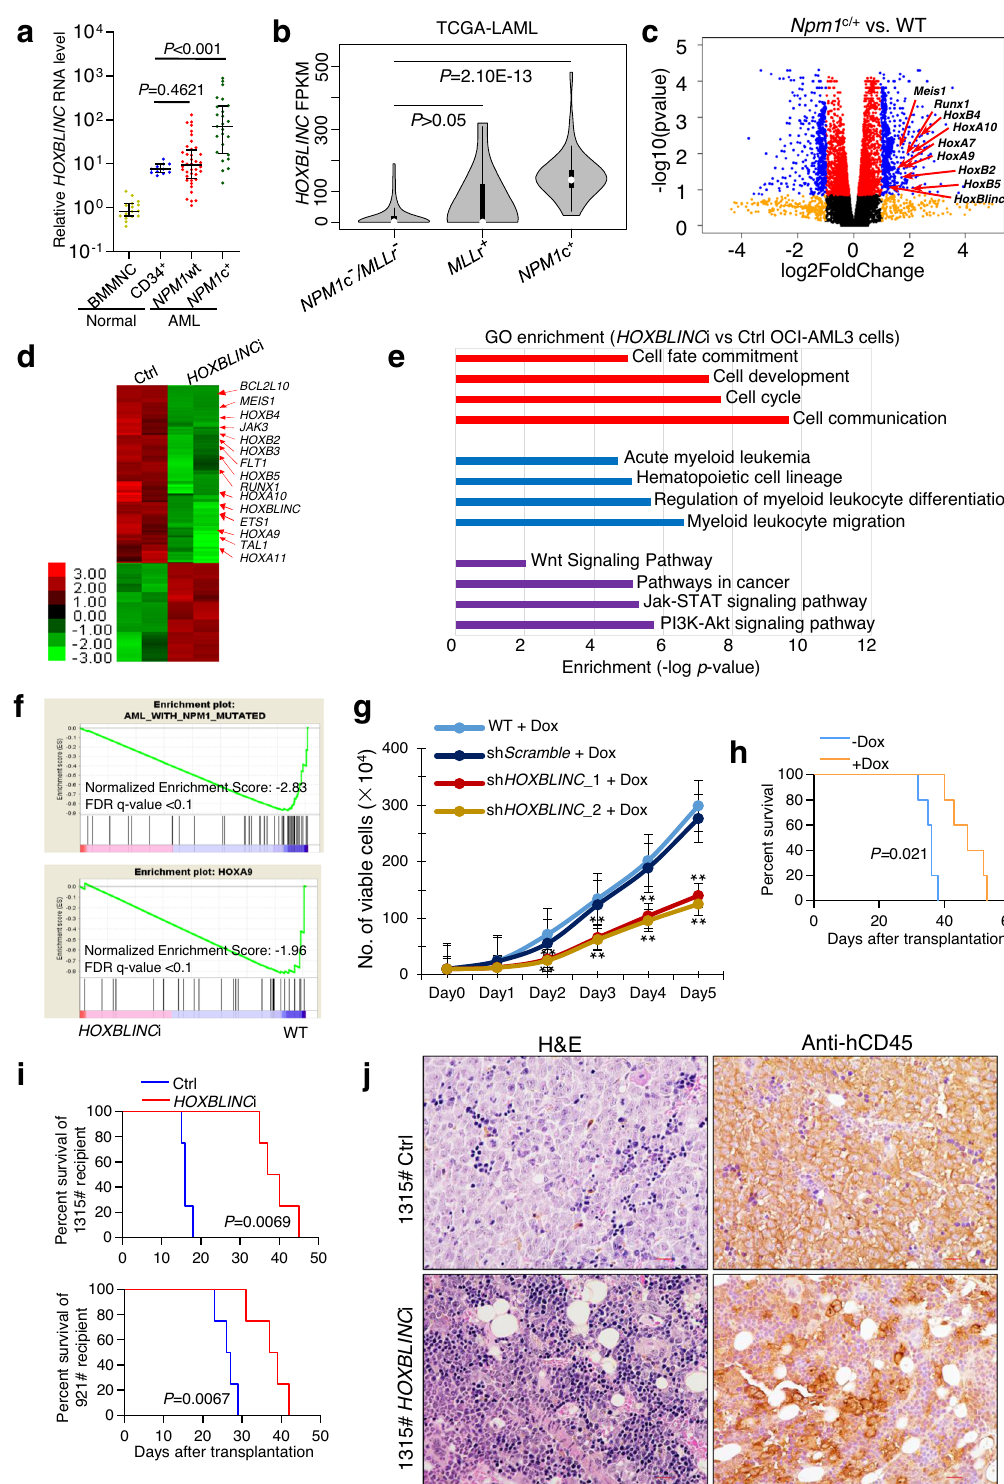
Dox-inducible HOXBLINC KD OCI-AML3 clone into NOD-scid IL2R γ null (NSG) mice (2 × 10 5 cells/mouse) followed by Dox induction or vehicle treatment, the Dox-treated recipient mice had signi fi cantly prolonged survival as compared to the recipients without Dox treatment (Fig. 1h). At 30 days after transplantation, Dox-treated mice had signi fi cantly lower hCD45 + chimerism